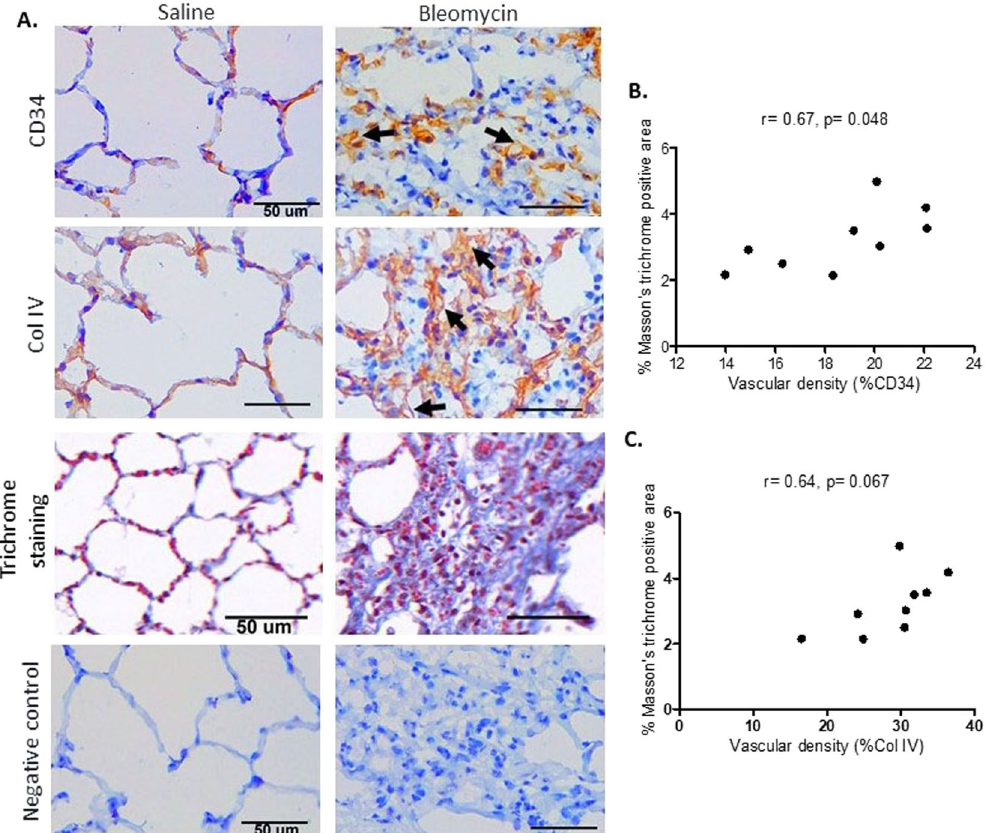
Figure 1. Alveolar capillaries in saline and bleomycin treated lung segments. ( A ) The panels show representative histological sections of either saline-infused (left-side images), or bleomycin-infused (right-side images), lung segments taken from the same sheep. The top two panels show sections that were immuno- stained with antibodies against either CD34 or collagen type IV to detect capillaries in parenchyma. Arrows show large and dilated capillaries in bleomycin treated segment. The third panel shows representative Masson’s trichrome-stained sections that were used to determine fibrotic fraction. Primary antibodies were omitted in the negative control (fourth panel). Graphs show the relationship between vascular density and fibrotic fraction in bleomycin infused lung segments immuno-stained with CD34 ( r = 0.67, p = 0.048) ( B ) and collagen type IV ( r = 0.64, p = 0.067) ( C ) (n = 9 sheep). Scale bars = 50 µ